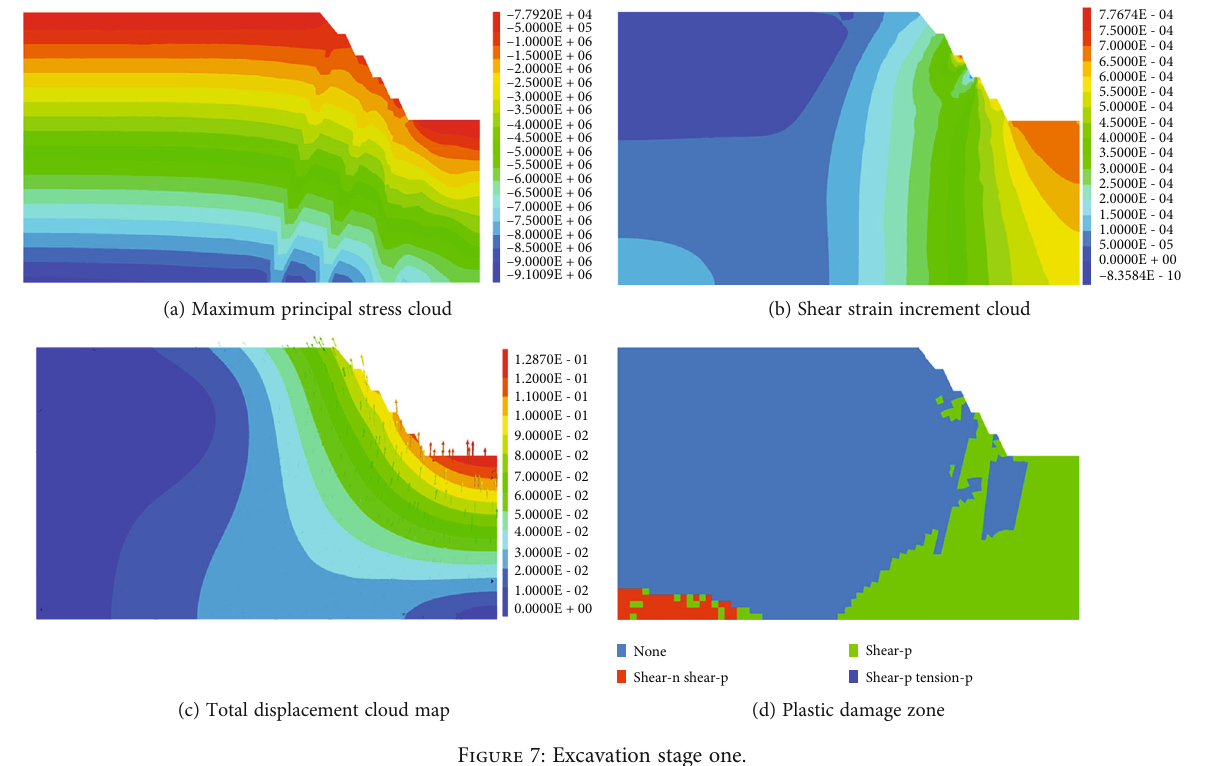
Figure 7: Excavation stage one.